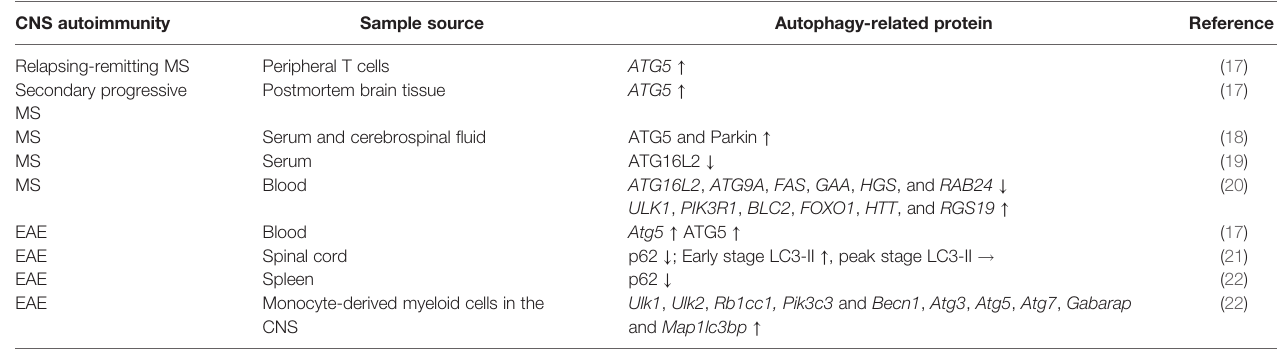
TABLE 1 | Autophagy is altered in MS and